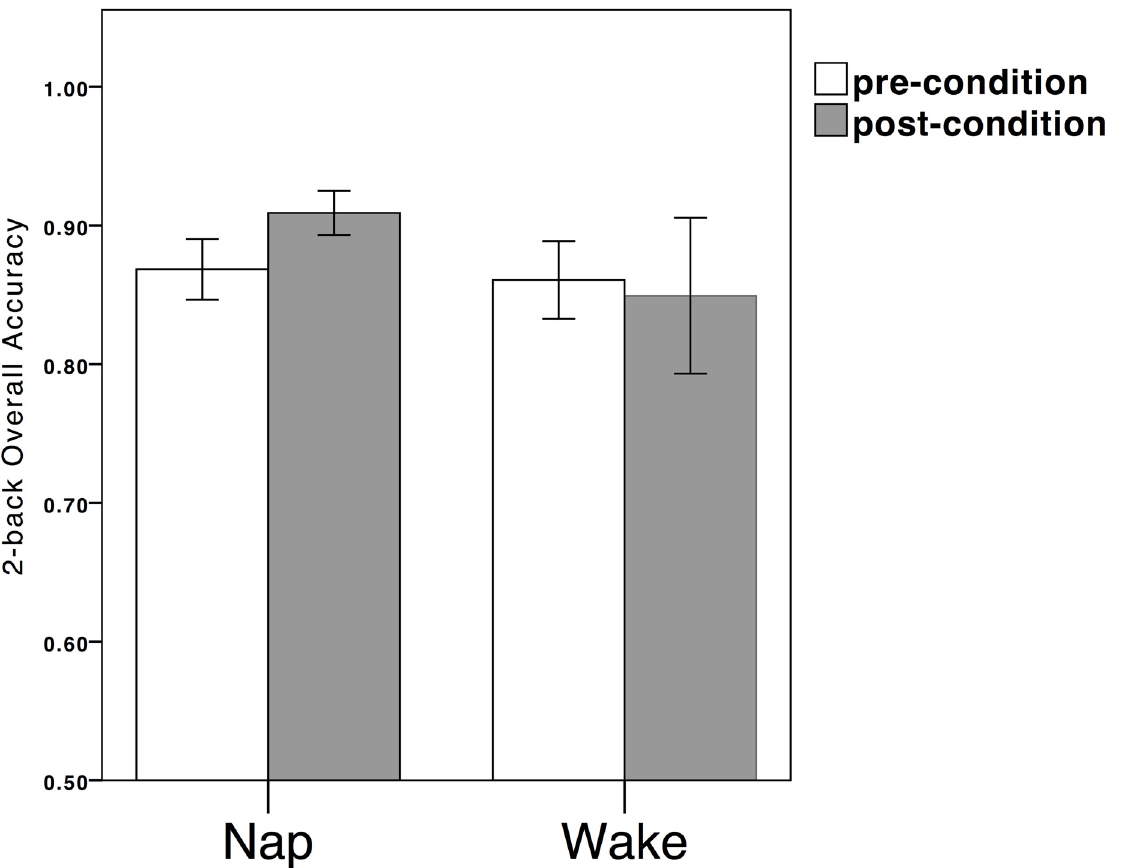
Fig 1. Significant improvement on the 2-back overall accuracy at posttest for the